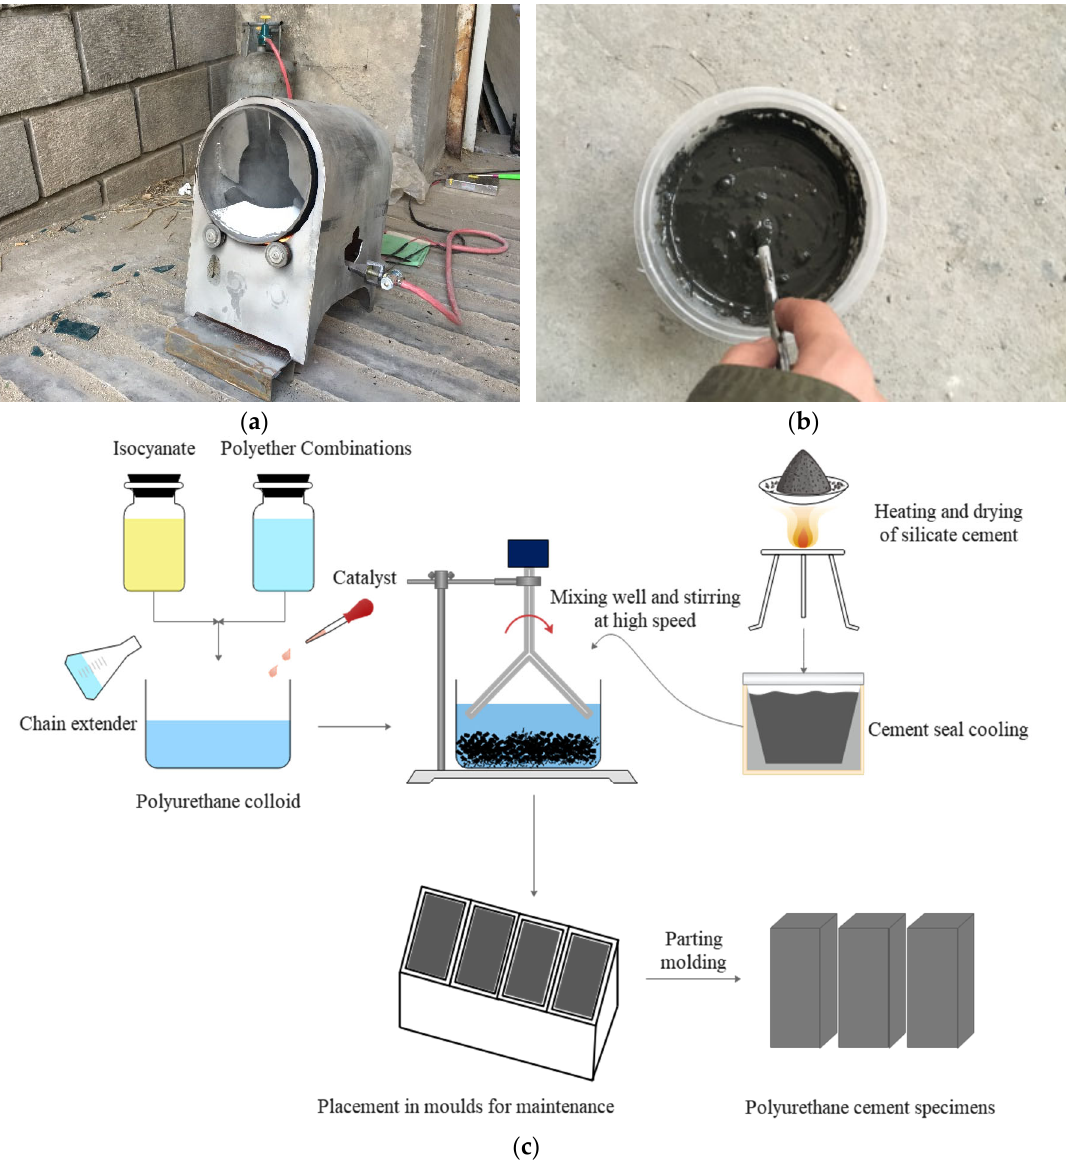
Figure 12. The preparation process of polyurethane cement: ( a ) stir frying cement; ( b ) stirring polyurethane cement; ( c ) preparation process flow chart.